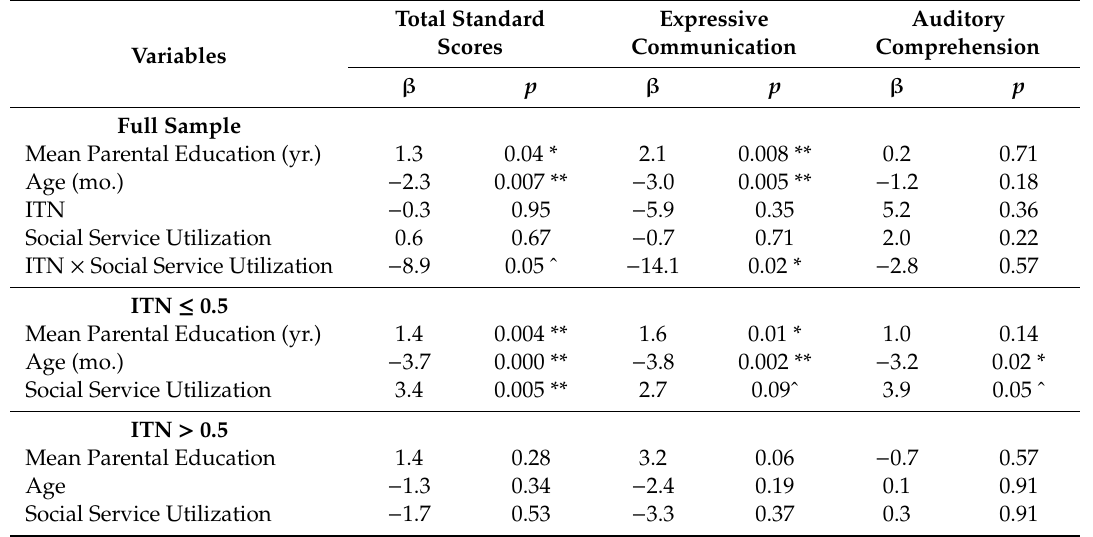
Table 2. Multivariate linear regression modeling infant Preschool Language Scale 5 ® (PLS) scores.